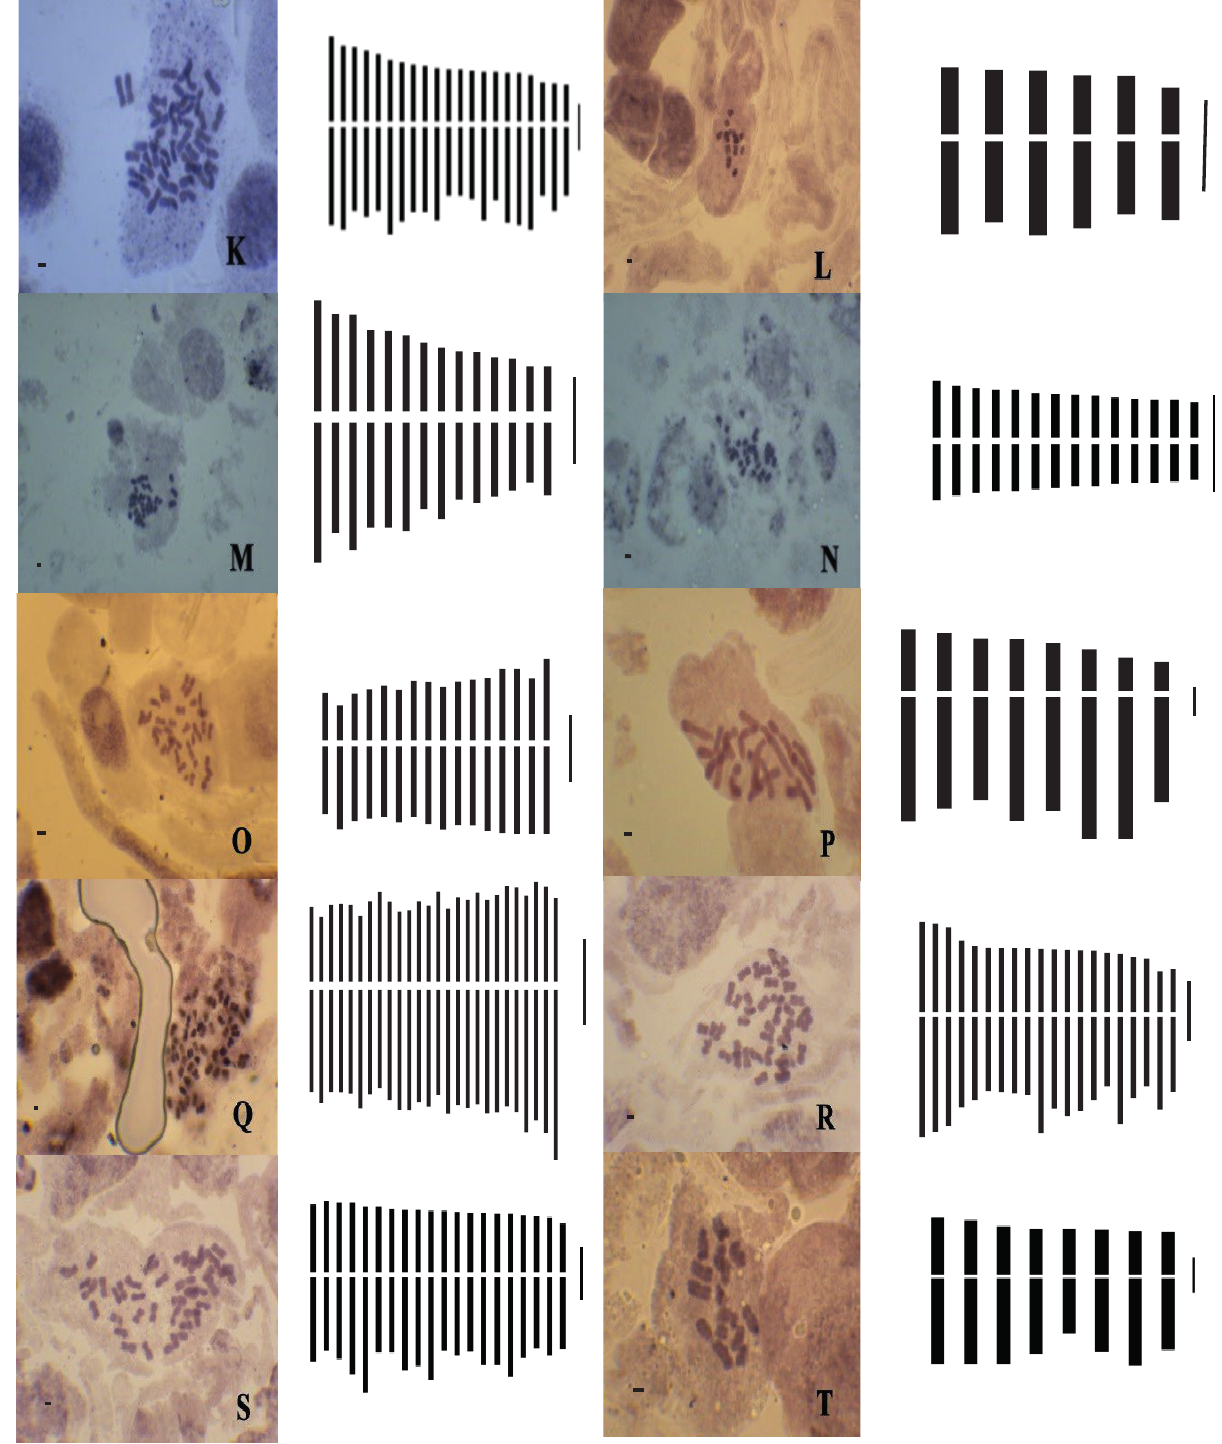
Figure 2. Somatic metaphase chromosome, Ideogram of each population is on the right side of the image: K: Phragmites australis (2 n = 42); L: Plantago atrata (2 n = 12); M: Prunella vulgaris (Dalamper) (2 n = 28); N: Prunella vulgaris ( Bostanabad) (2 n = 28); O: Ranunculus dolusus (2 n = 32); P: Ranunculus kotschyi (2 n = 16); Q: Scrophularia umbrosa (2 n = 52); R: Senecio pseudoorientalis (Hashtroud) (2 n = 40); S: Sene- cio pseudoorientalis )Bolaghvar) (2 n = 40); T: Trifolium pratense (2 n = 16). Scale bar: 1